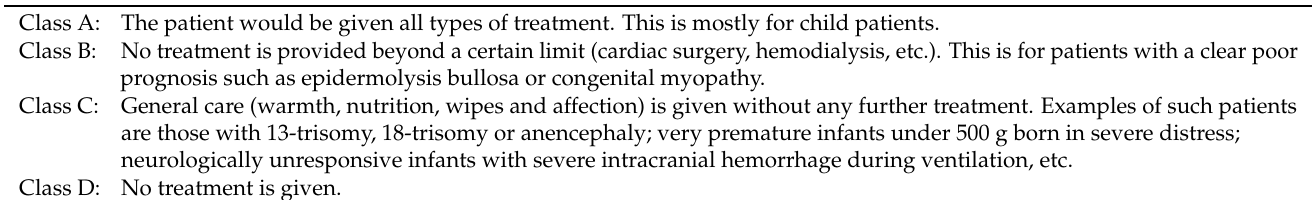
Table 1. Post-decision medical